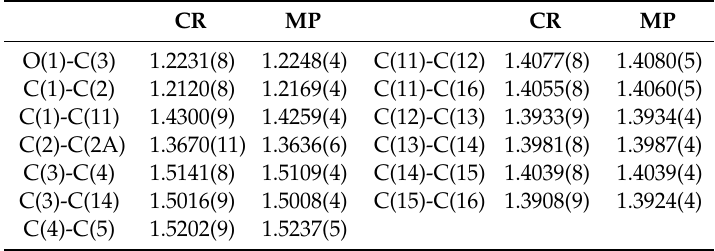
Figure 1. View of 1 . Table 1. Bond lengths in 1 .